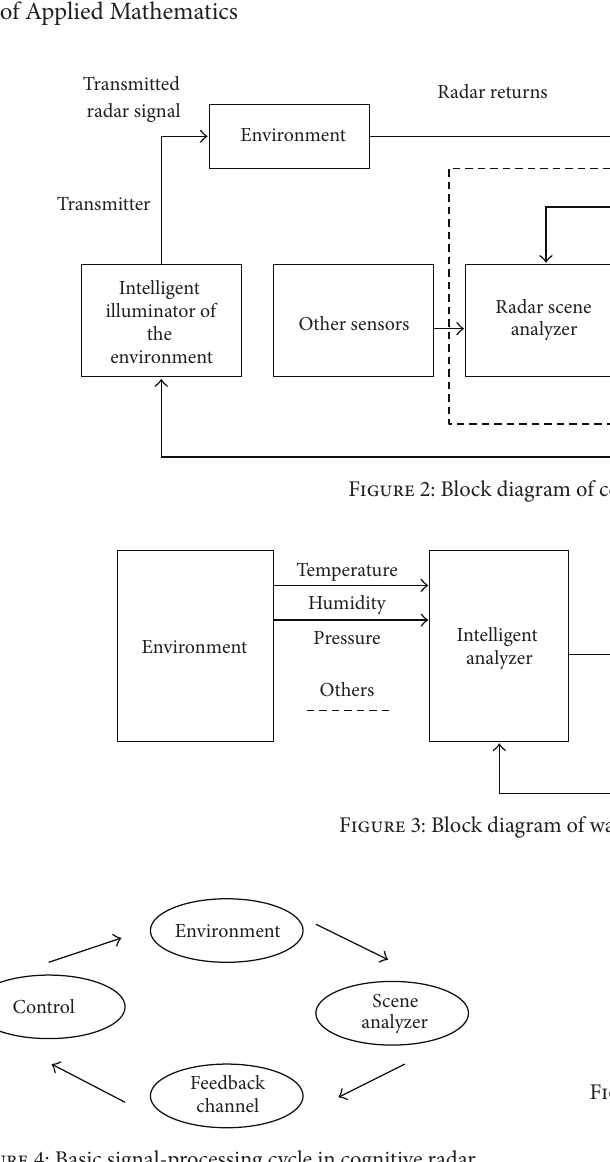
Figure 4: Basic signal-processing cycle in cognitive radar.